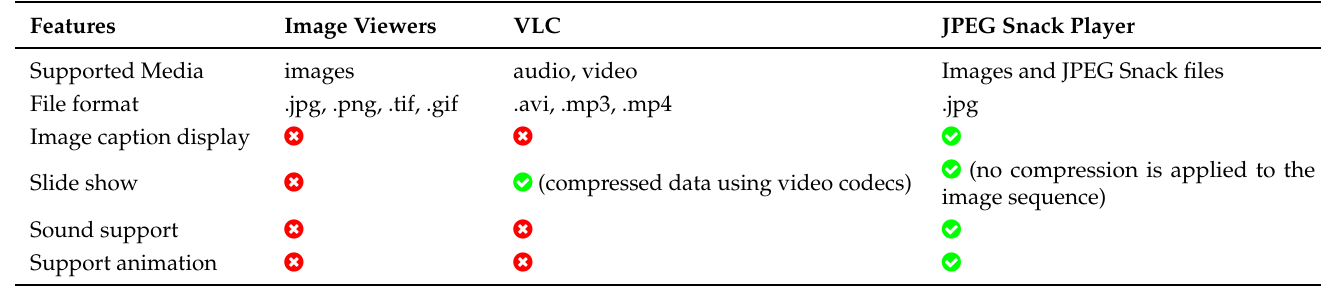
Table 3. Comparison of features of JPEG Snack player with the existing media